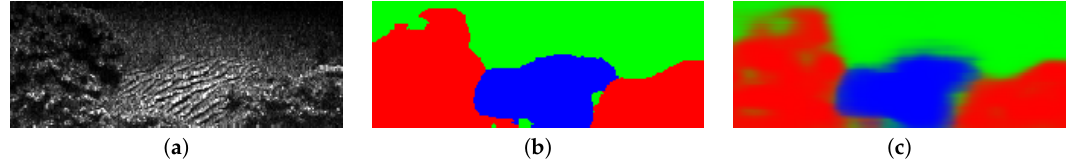
Figure 8. Example of ( a ) a set of informative swaths and the corresponding segmented images using ( b ) SCM and ( c ) MCM.